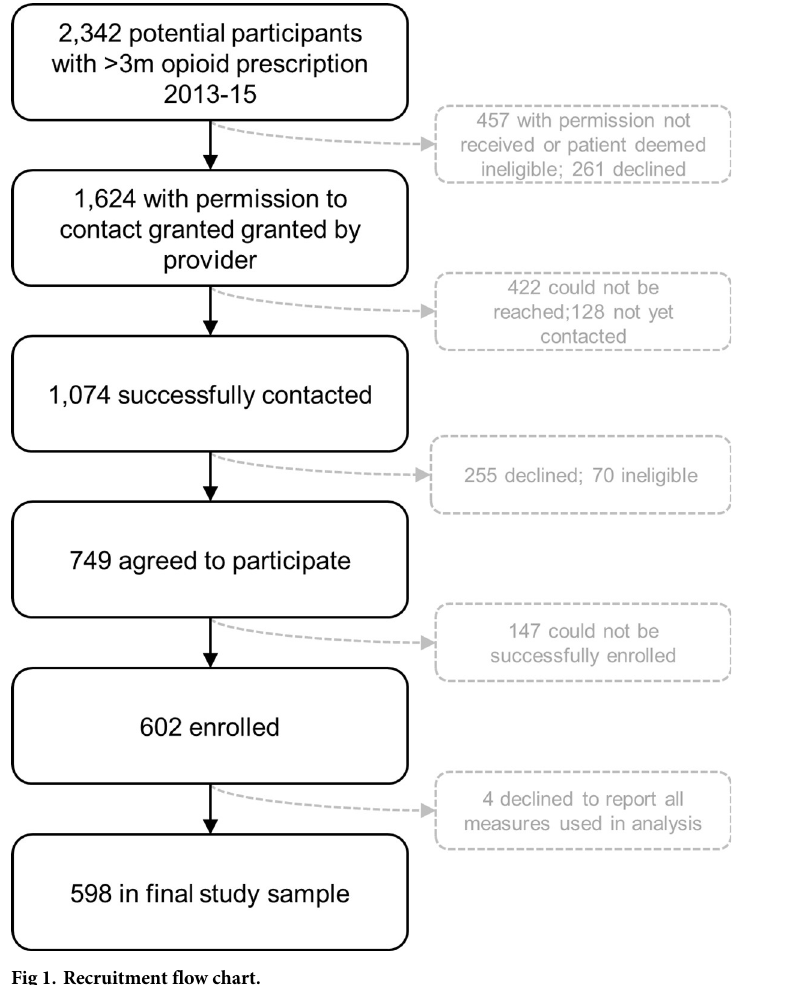
Fig 1. Recruitment flow